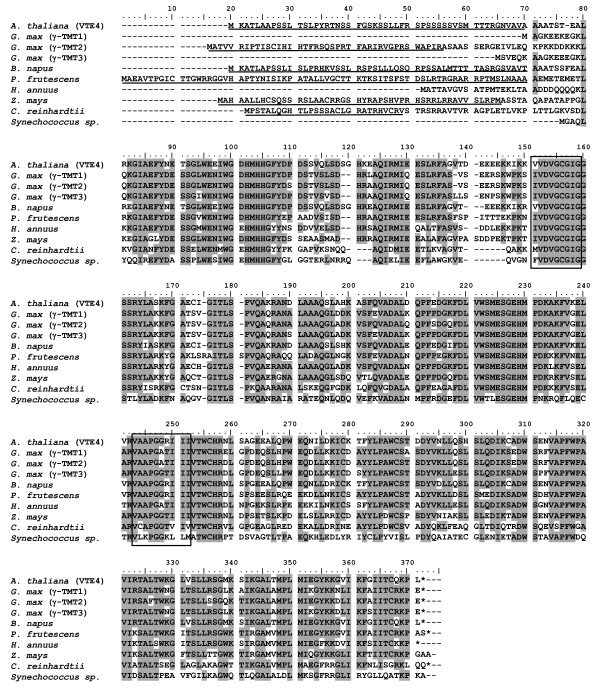
Amino acid sequence alignment of γ-TMT proteins. Comparison of the deduced amino acid sequences of γ-TMT1, γ-TMT2, and γ-TMT3 with those of other plants green algae and cyanobacterium. For B. napus (EU637012.1) and H. annuus (DQ229832.1), only one of the sequences was used for alignment. The sequences were compared with A. thaliana γ-TMT (VTE4) as a standard; identical residues in other sequences are shaded, and gaps introduced for alignment purposes are indicated by dashes (-). Lines under amino acid sequences represented plastid transit peptides, which were predicted by using ChloroP1.1 [37]. Blocks surrounded by black boxes are conserved SAM-binding domains, as reported by Shintani and DellaPenna [21].